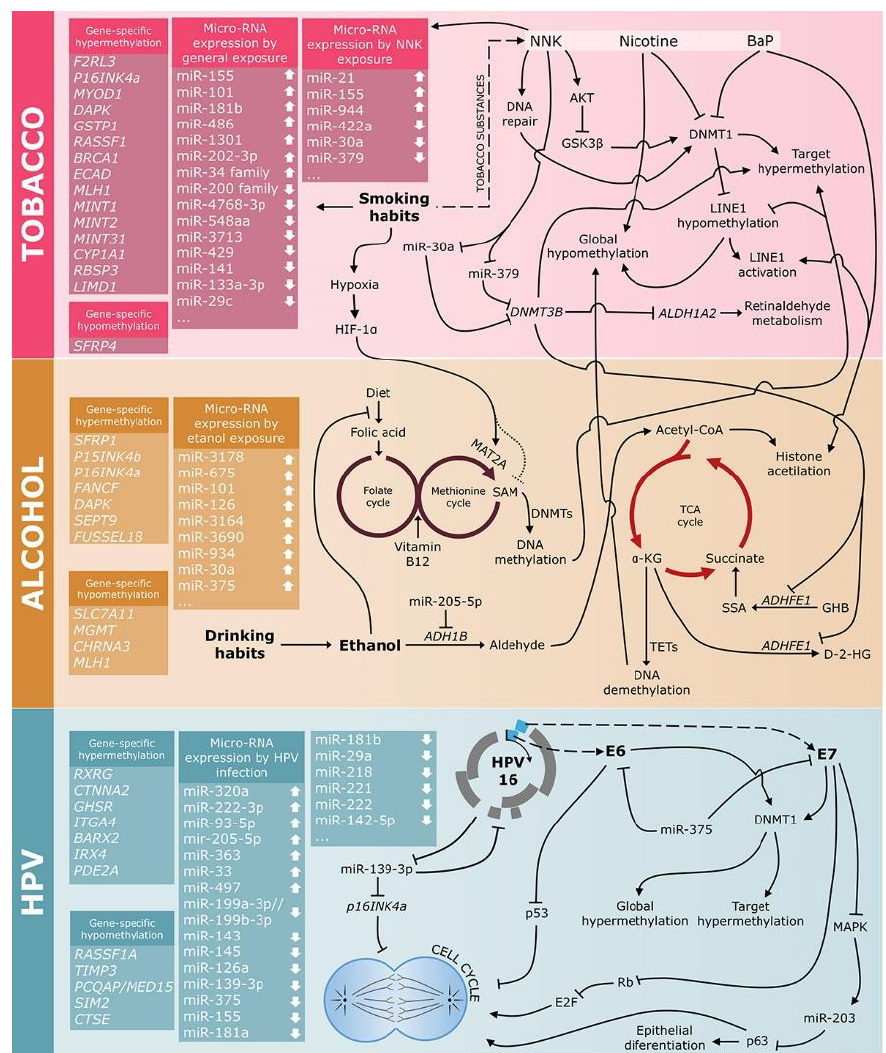
Figure 2. Risk factors associated with HNSCC development affect DNA methylation and miRNA expression, showing different mechanisms by which tobacco components, alcohol, and HPV in- fection may lead to aberrant DNA methylation profiles and aberrant miRNA expression. NNK, 4-(methylnitro-samino)-1-(3-pyridyl)-1-butanone; BaP, benzo(a)pyrene; TCA Cycle, tricarboxylic acid